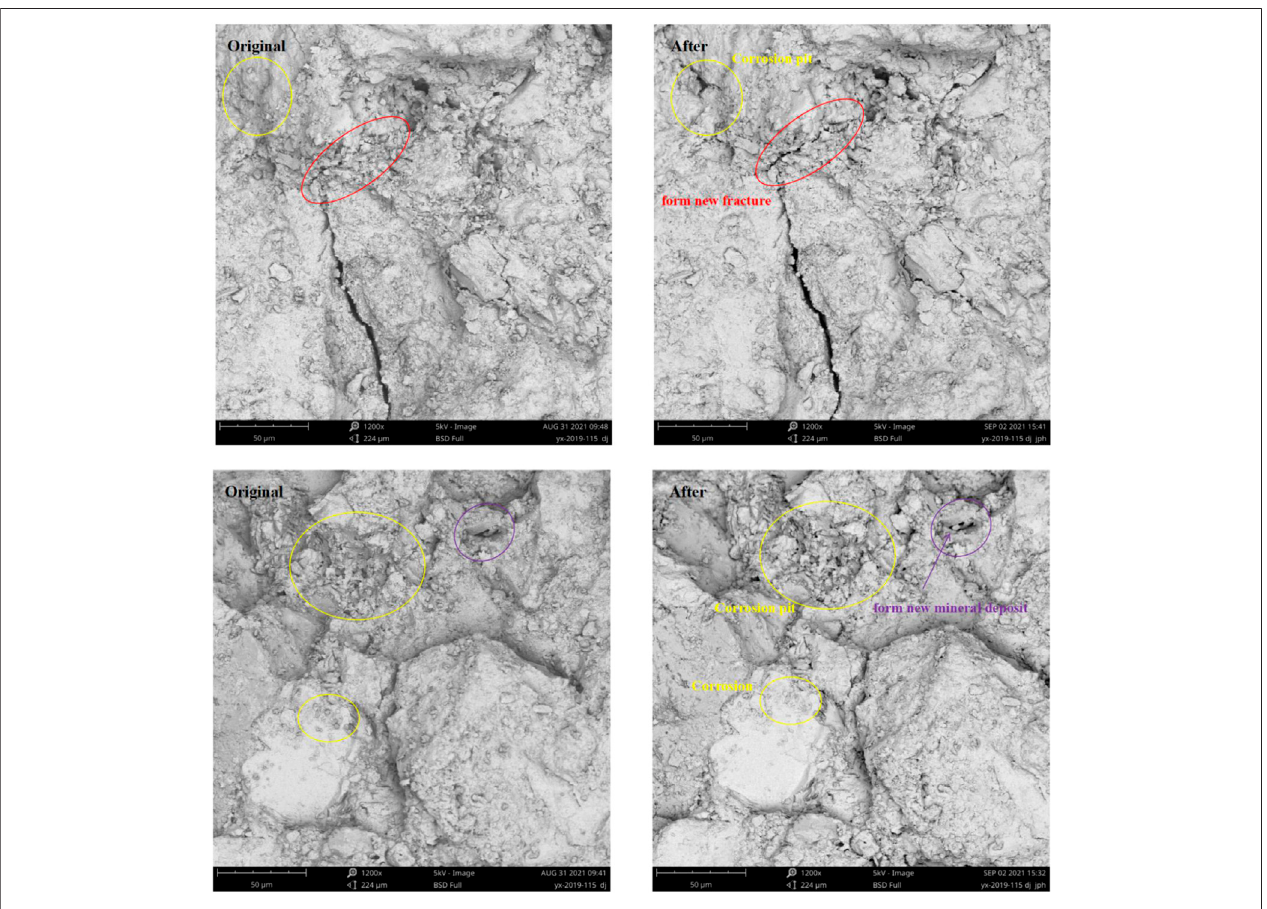
FIGURE 7 | Effect of supercritical CO 2 on microstructure.